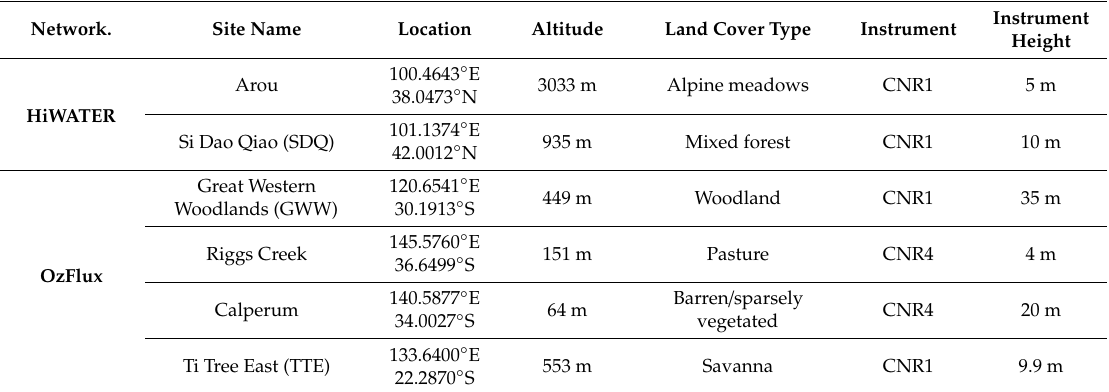
Table 4. Information on the T-based sites.